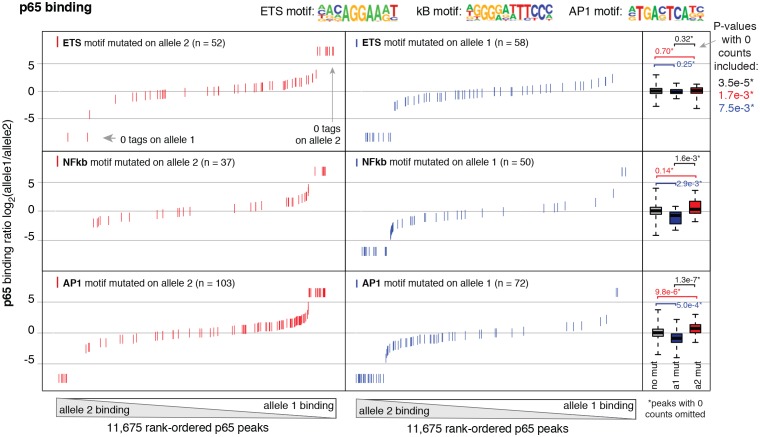
Binding of p65 at mutated motifs at each allele p65 (NFκB) binding was measured by ChIP-seq in a HAEC donor with whole-genome sequencing information.Allele-specific p65 binding was calculated at heterozygous loci (y-axis is p65 binding ratio between alleles). Allele-specific motif mutations were calculated as instances where an allele mutated the ETS (top panels), NFκB (middle panels), or AP (bottom panels) canonical binding motif. Box plots to the right show the distribution of p65 peaks in one of three categories: all heterozygous peaks without mutations in grey; peaks where motifs were mutated on allele one in blue; and peaks where motifs were mutated on allele2 in red. p-values result from two-sided t-test and exclude peaks where 0 counts are observed on one of the two alleles. These sites were excluded because the allele-specific binding ratio (y-axis) should be ± infinity in instances of 0 counts on one allele. To avoid complications this brings to the t-test, we excluded these sites. Thus, p-values are very conservative because the sites with 0 counts on one allele are highly informative for the effect of motif mutations on binding (i.e. they are the most extreme examples). The exception is the top panel, where the p-value was only significant when peaks with 0 counts were scaled to ± 7.5.